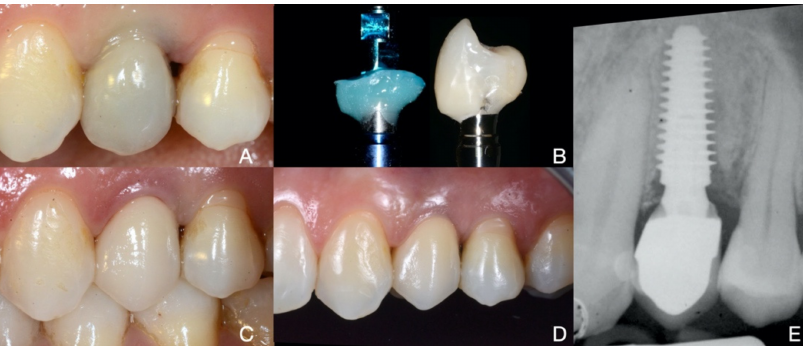
Figure 2. A provisional screw-retained crown ( A ) is set in place in Section 2.4. After three months, the emergence profile is transferred to the technician through the individualized transfer technique ( B ) to reproduce the same emergence profile of the provisional in the final crown. The PS final rehabilitation ( C ) is delivered. After three years the crown shows acceptable integration ( D ) and good stability of the buccal gingival zenith. On the right ( E ) the X-ray is acquired at the time of the final crown delivery.